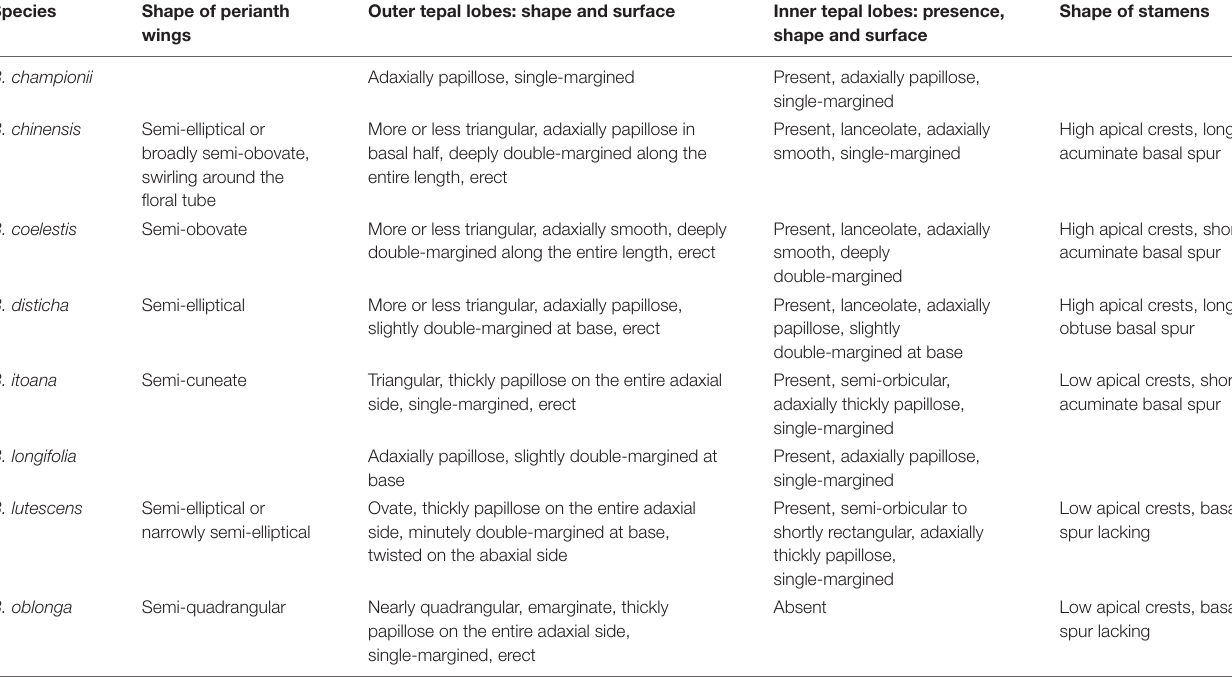
TABLE 2 | Gross morphology of perianth and androecium in the studied specimens of Burmannia